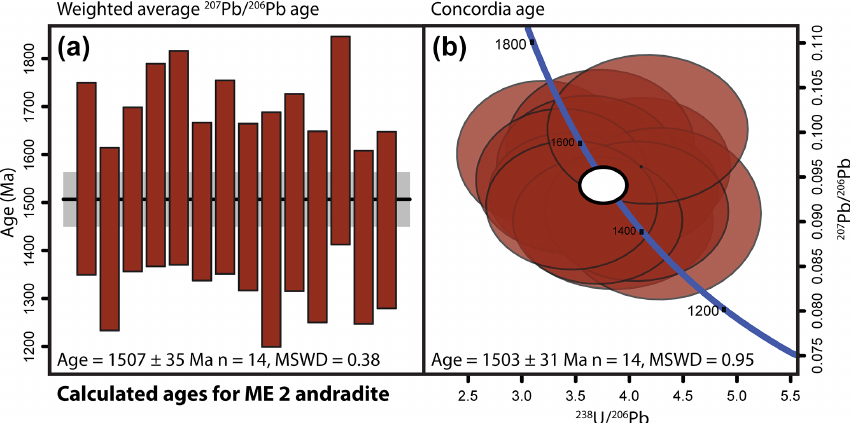
Figure B1. U–Pb age of ME 2 andradite. Panel (a) shows the weighted average 207 Pb / 206 Pb age, and panel (b) shows the concordia age on a Tera–Wasserburg concordia plot. For the weighted average, vertical rectangles are 2 σ uncertainties around calculated single-spot ages, with the black bar showing calculated weighted mean age and the grey rectangle showing associated 95% confidence interval uncertainty. For the concordia plot, each ellipse shows the 2 σ uncertainty around each analysis, with the white ellipse representing 95% confidence interval uncertainty around the calculated concordia age. Weighted mean age and concordia age were calculated using ISOPLOTR (Vermeesch, 2018).